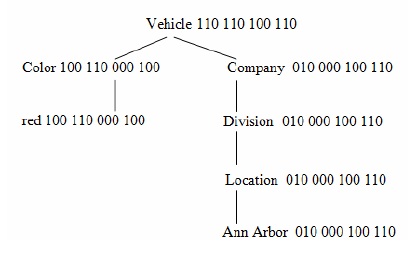
Figure 4. Query signature